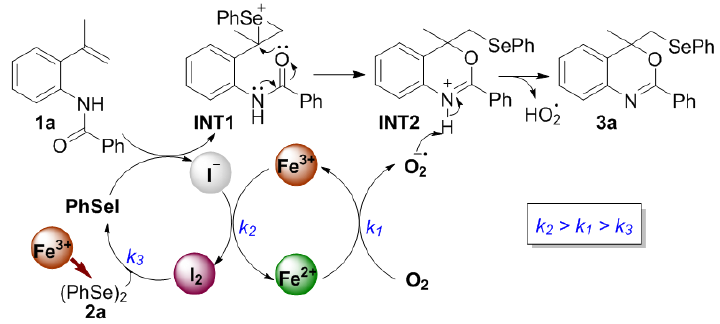
Figure 3. Proposed reaction mechanism.